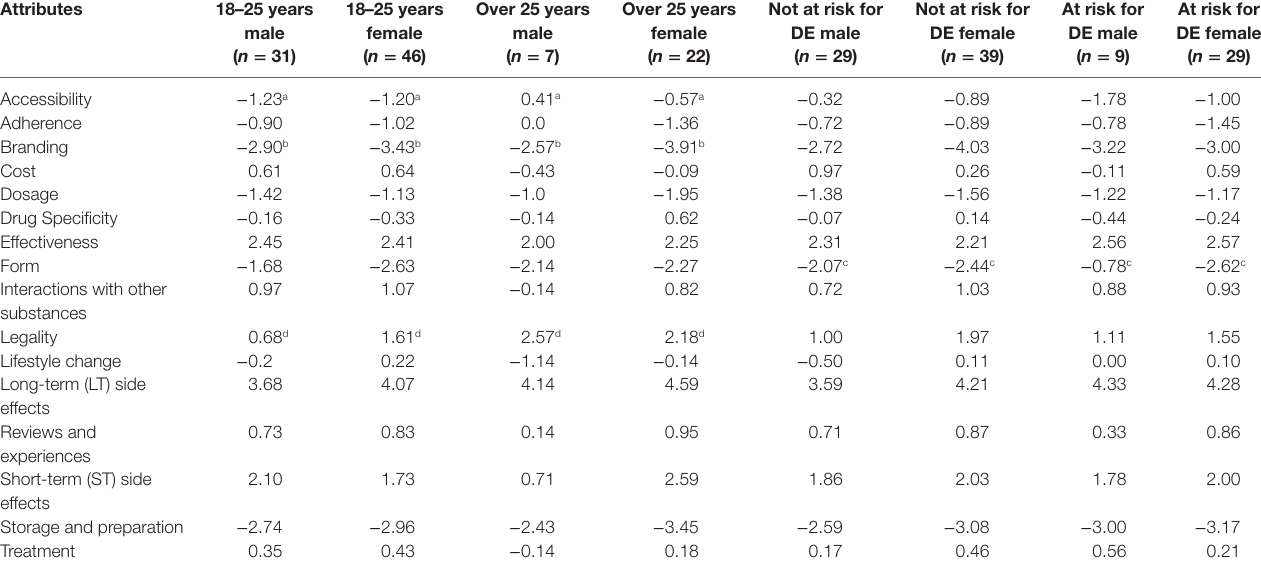
TaBle 4 | Ranked means Best–Worst Scale attribute scores within 2,4-DNP scenario by age and gender.